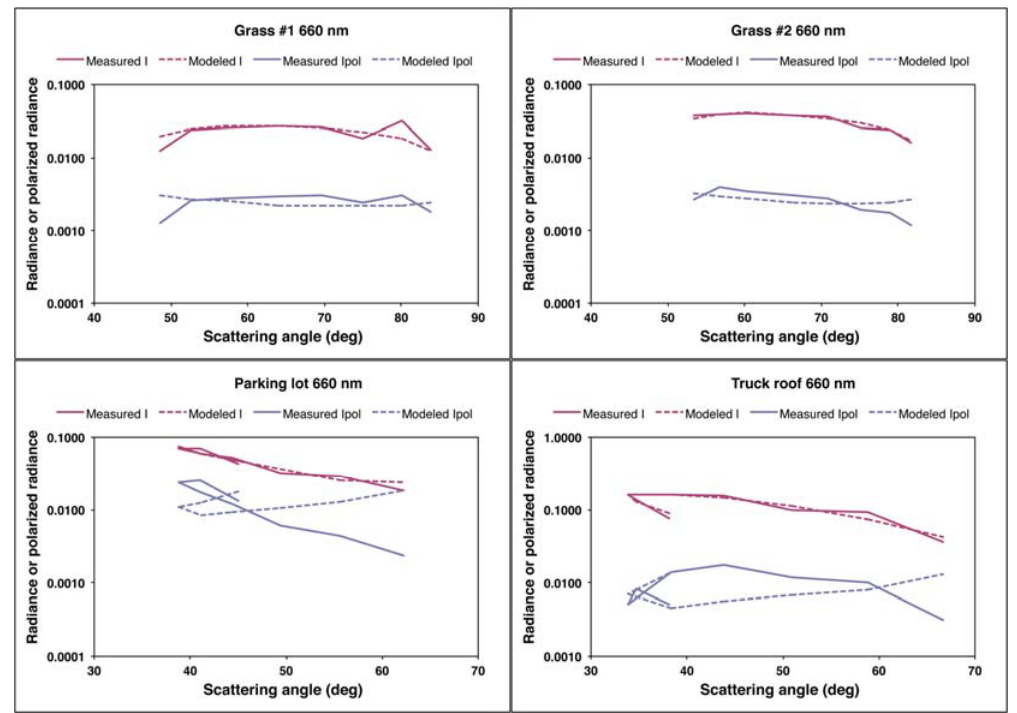
Figure 8. Similar to Figure 6, but for Step 2 of the modeling, i.e. , reflection of diffuse skylight (second term on right hand side of Equation (22)) is